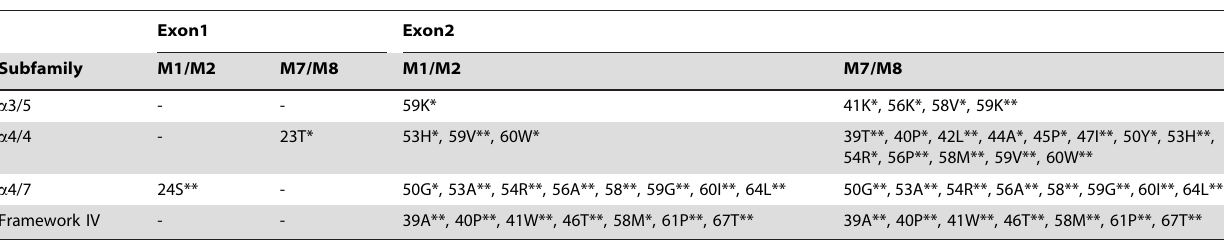
Table 6. Positively selected sites in A superfamily.